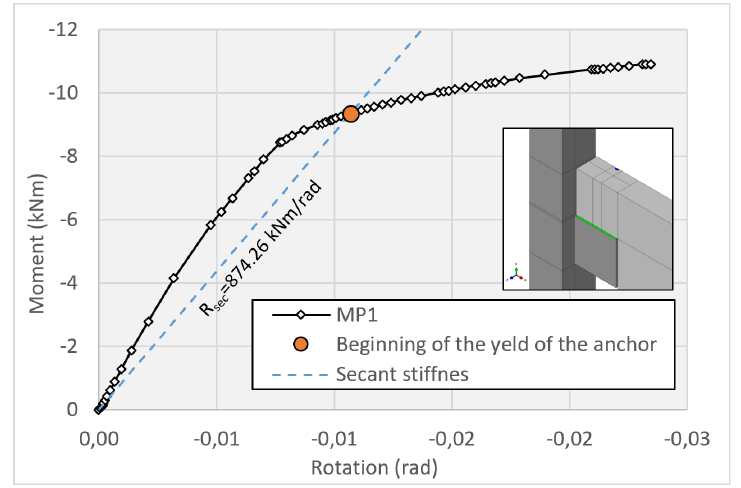
Figure 12. MP1 moment-rotation